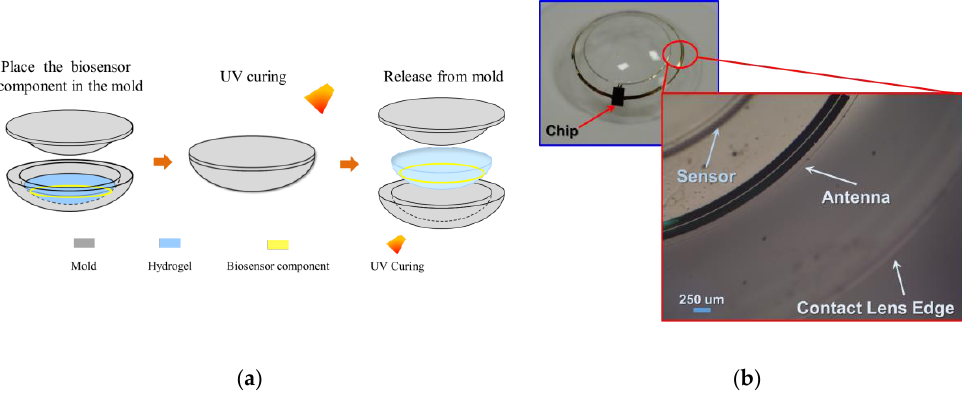
Figure 7. ( a ) Contact lens assembly process; ( b ) Assembled wrinkle free soft contact lens.